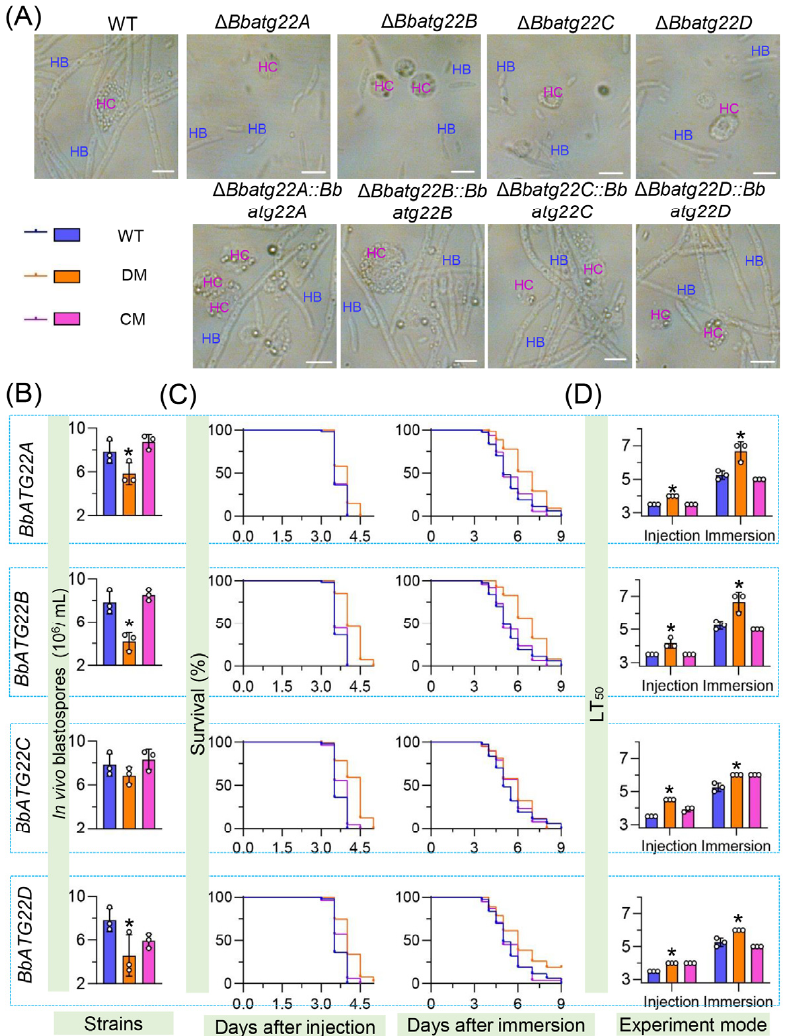
Figure 7. Assays for fungal pathogenic growth and virulence. To evaluate fungal pathogenic growth, conidia (500 cells) were injected into the hemoceol of Galleria mellonella larvae and cultured at 25 °C. Microscopic view ( A ) and production ( B ) of in vivo blastospore (hyphal body) were examined at 3.5 d post infection. Fungal virulence was determined by intrahemocoel injection of 500 conidia per larva and immersing the hosts in a 10 7 conidia/mL suspension, respectively. The survival percentage ( C ) was recorded daily and used to calculate the median lethal time (LT 50 ) ( D ) using Kaplan–Meier analyses. HB: hyphal body; HC: insect hemocytes. WT: wild type; DM: gene disruption mutant; CM: complementation mutant. *: p < 0.05 for Tukey’s HSD tests. Error bars: standard deviation. Scale bars: 10 µm.